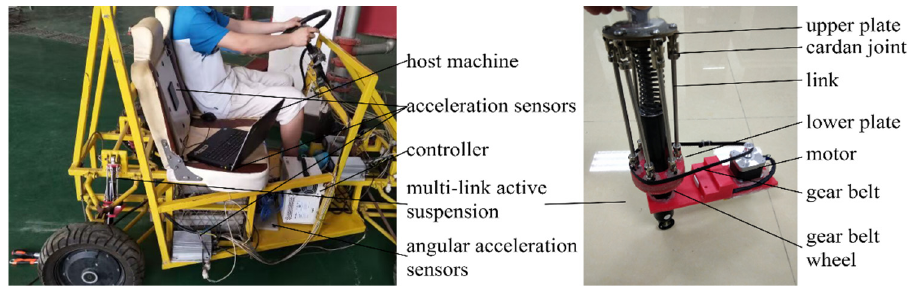
Figure 12. Multi-link active suspension and test.